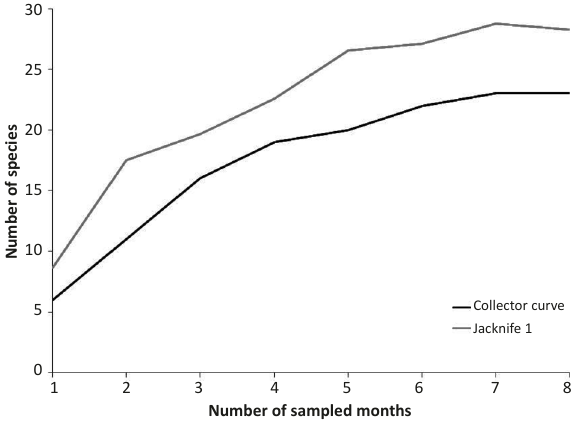
Figure 2. Cumulative number of mammal species observed and estimated by Jackknife 1 procedure built from the months sampled in the National Forest of Silvânia, state of Goiás,